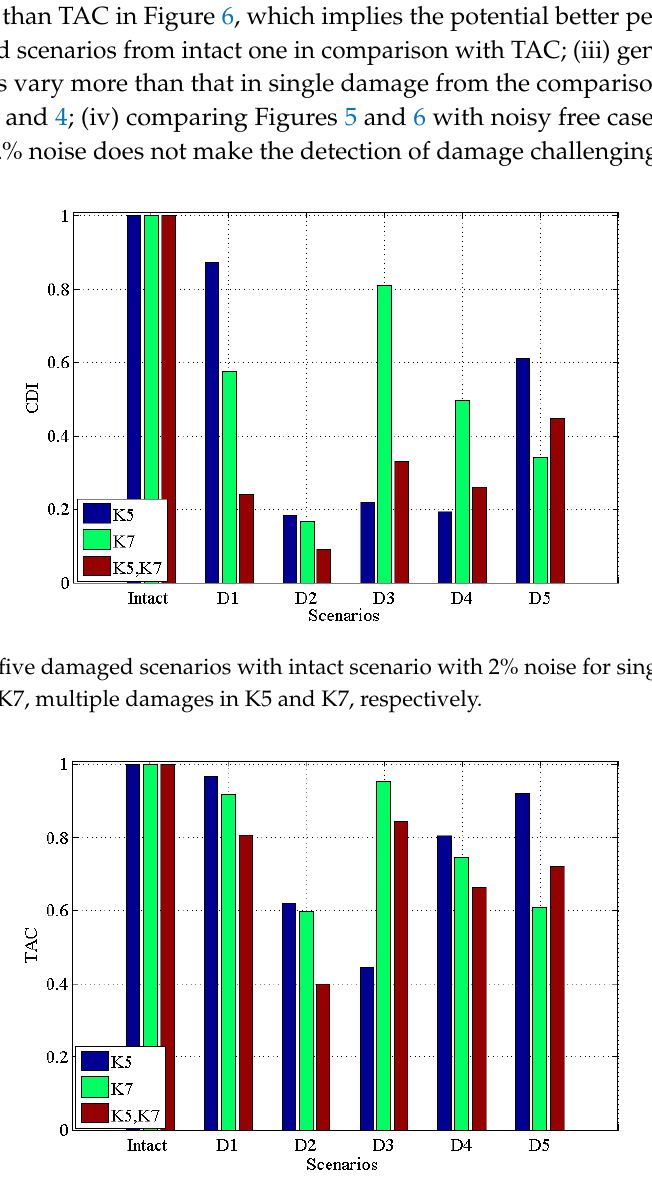
Figure 6. TAC for five damaged scenarios with intact scenario with 2% noise for single damage in K5, single damage in K7, multiple damages in K5 and K7, respectively.